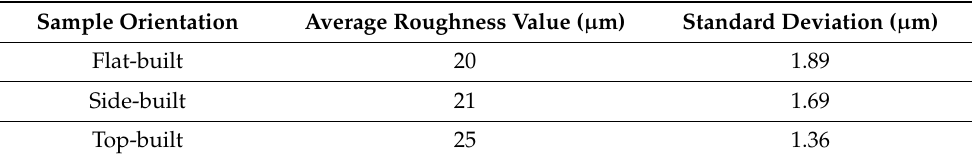
Table 1. Average surface roughness parameter (Ra) data were measured from the three as-built EBM Ti6Al4V samples built in different orientations.